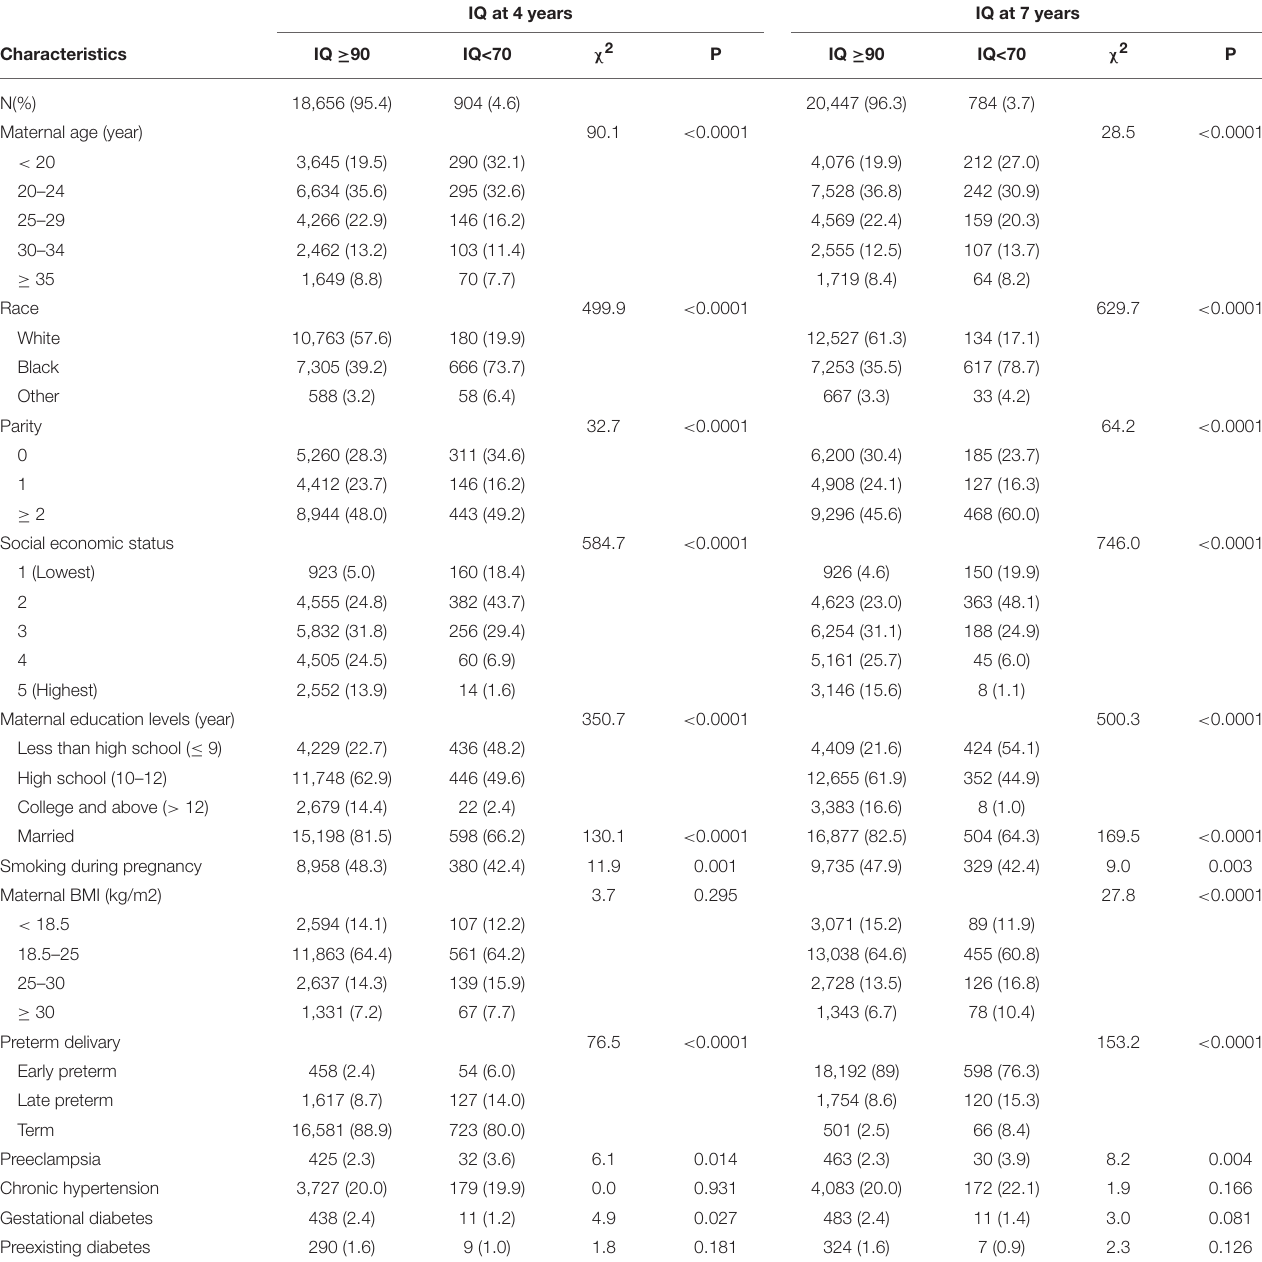
TABLE 1 | Maternal characteristics and perinatal outcomes by IQ. IQ at 4 years IQ at 7